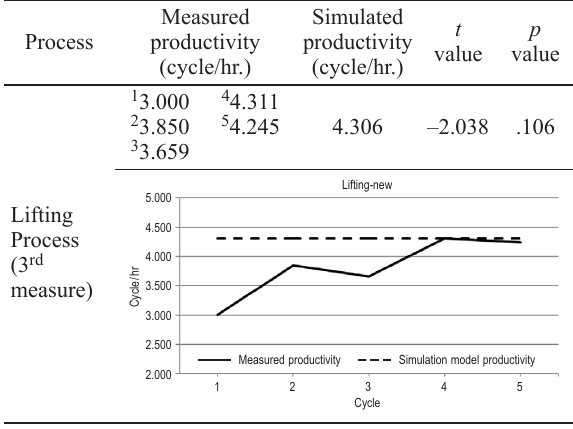
Table 10. T-test results between the measured and simulated productivity in the lifting process (3 rd measure) Measured Simulated Process productivity productivity (cycle/hr.) (cycle/hr.) 1 3.000 4 4.311 2 3.850 5 4.245 4.306 –2.038 .106 3 3.659 Lifting Process (3 rd measure)